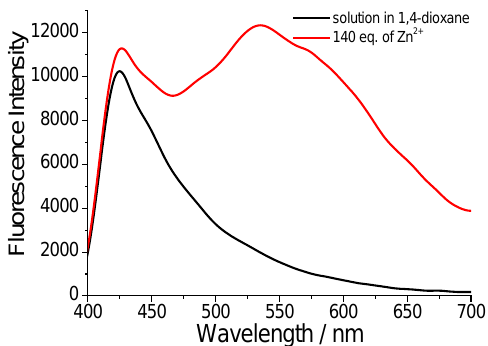
Figure 12. Fluorescence emission spectra change of solution 1 in 1,4-dioxane (kept for three months later) upon the addition of 140 eq. of Zn 2+ .